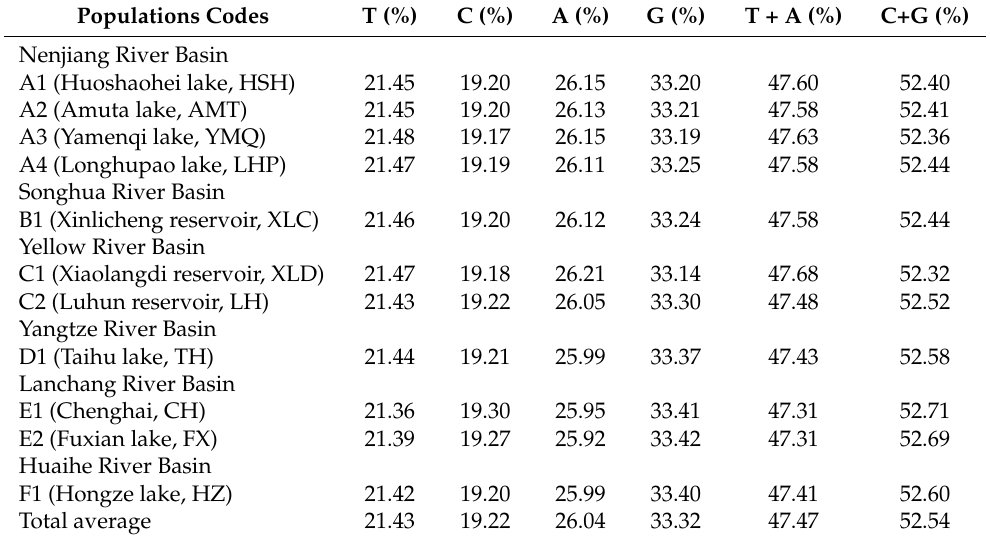
Table 1. The average nucleotide composition of N. taihuensis in different